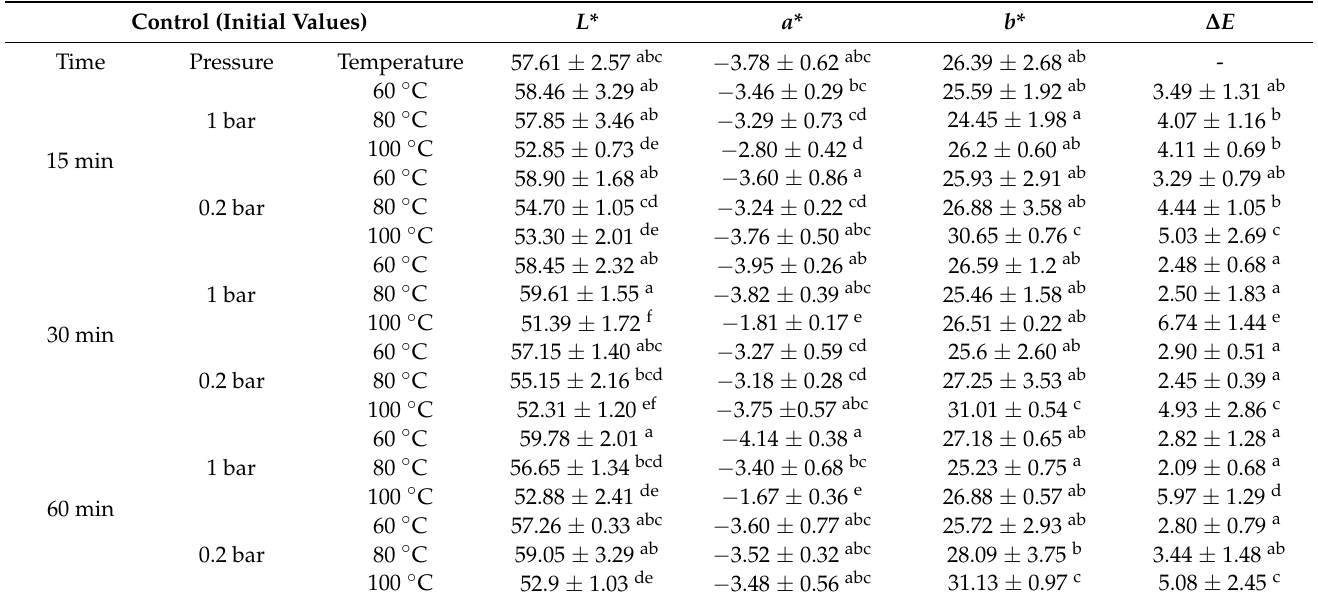
Table 2. Changes in CIE values and total color difference of sprout barley powder treated by different heating